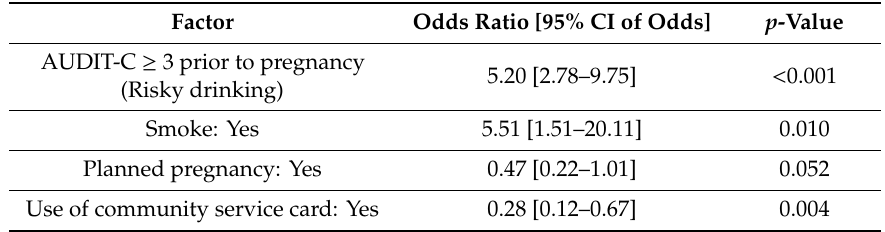
Table 3. Factors associated with drinking prior to pregnancy recognition ( n = 265) 1,2